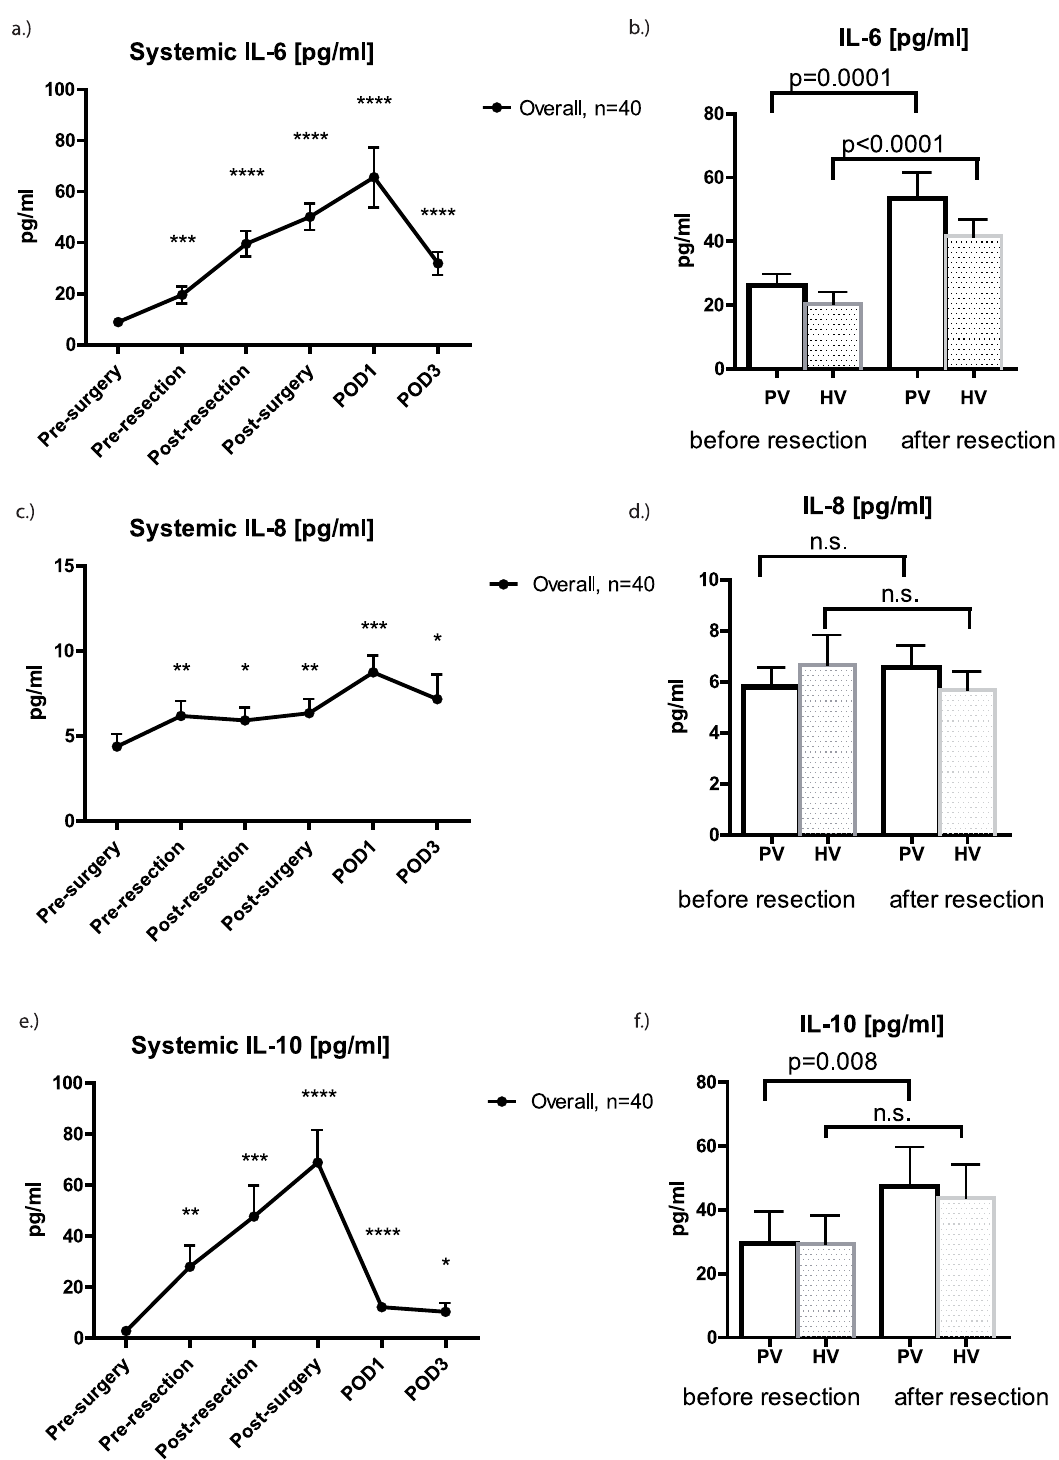
Fig 2. Perioperative alteration of pro- (IL-6, IL-8) and anti-inflammatory cytokines (IL-10). Systemic IL-6 (A) , IL-8 (C) and IL-10 (E) levels significantly increased perioperatively compared to baseline values. Graphs show mean cytokine concentrations [pg/ml] ± SEM. There was a significant increase in IL-6 during liver resection in the portal vein (PV; p = 0.0001) and hepatic vein (HV; p < 0.0001) respectively (B) . Similar to that IL-10 increased significantly in the PV (p = 0.008) but not HV (F) . IL-8 levels measured in the in and out flow remained virtually unchanged ( D) . Statistical significance compared to baseline values is abbreviated with * (p = 0.010 – 0.050), ** (p = 0.001 – 0.010), *** (p = 0.0001 – 0.001) or **** (p < 0.0001).